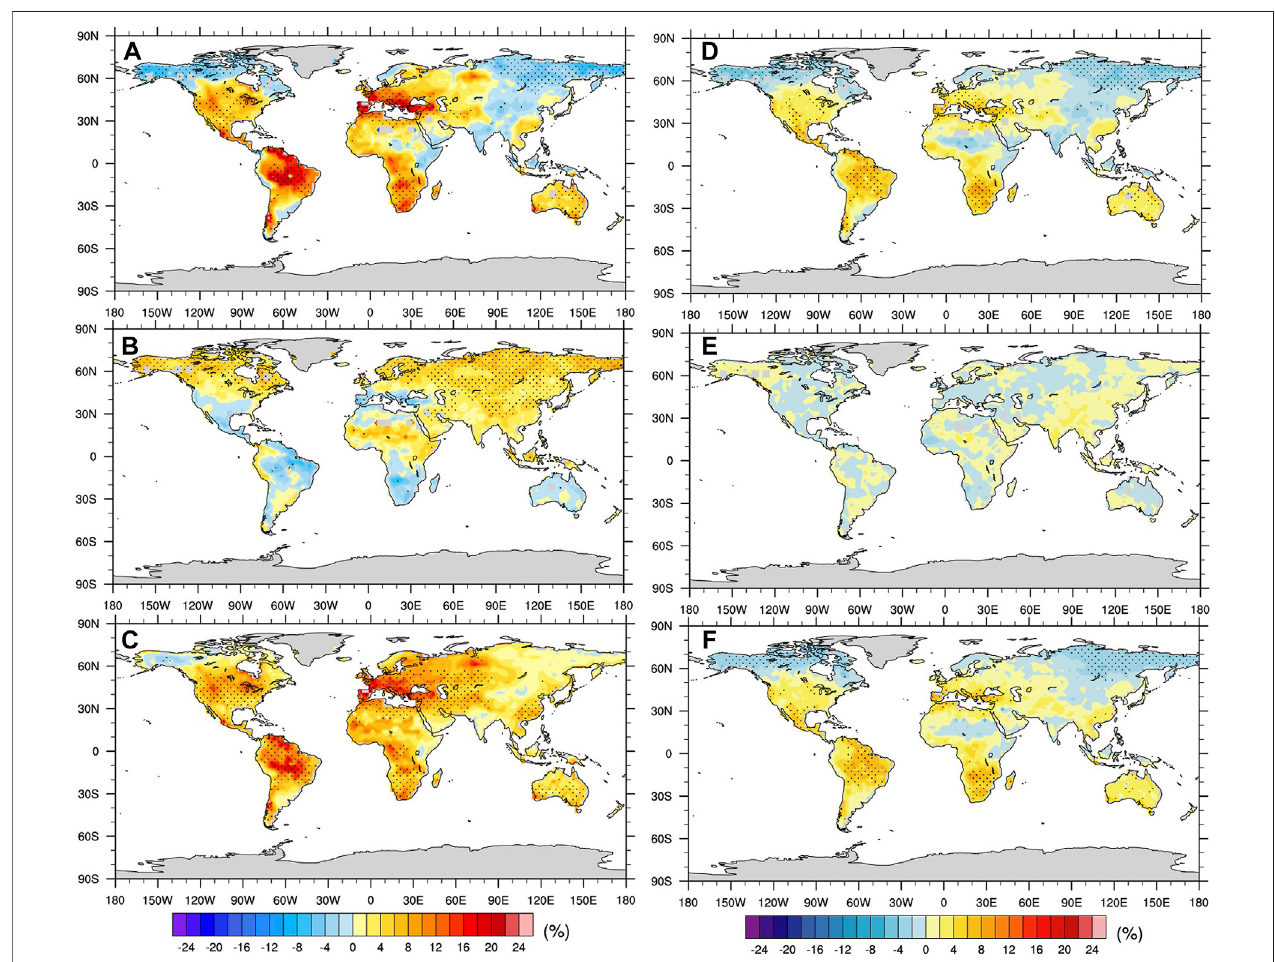
FIGURE 2 | Change in severe (left panels) and moderate (right panels) drought frequencies for 2070 – 2099 relative to 1970 – 1999 under the RCP4.5 emission scenario, due to the changesin (A,D) mean, (B,E) shape, and (C,F) both together of the PDSI PDF. The black dots in the fi gure represent more than 80% ofthe models which agree with each other on the sign